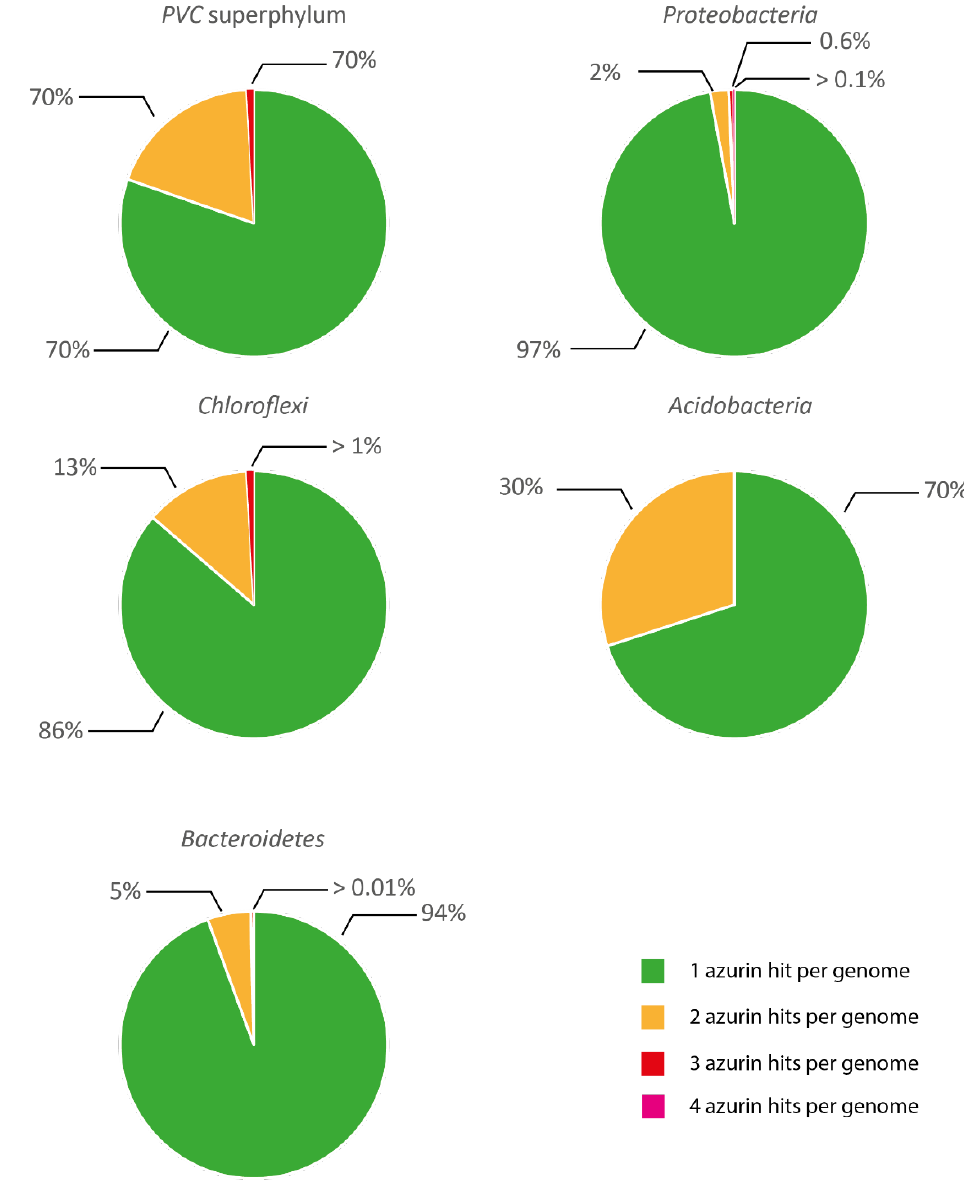
Figure 2. Number of azurin hits per genomes. Percentage of 1 azurin hit, 2 azurin hits, 3 azurin hits and 4 azurin hits on retrieved genomes.